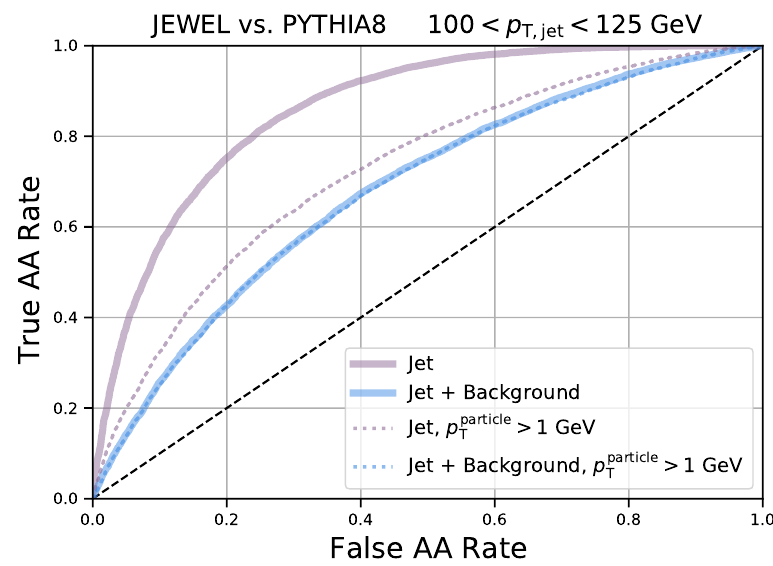
Figure 9 . ROC curves for PFNs trained with (i) PYTHIA8/JEWEL jets, (ii) jets clustered from a combination of PYTHIA8/JEWEL events with a thermal background, with event-wide constituent subtraction applied ( R = 0 . 25 ), (iii) PYTHIA8/JEWEL jets only considering jet constituents max with p 1 GeV, and (iv) jets clustered from a combination of PYTHIA8/JEWEL events with a T > thermal background, only considering jet constituents with p 1 GeV, with event-wide constituent T > subtraction applied ( R = 0 . 25 max